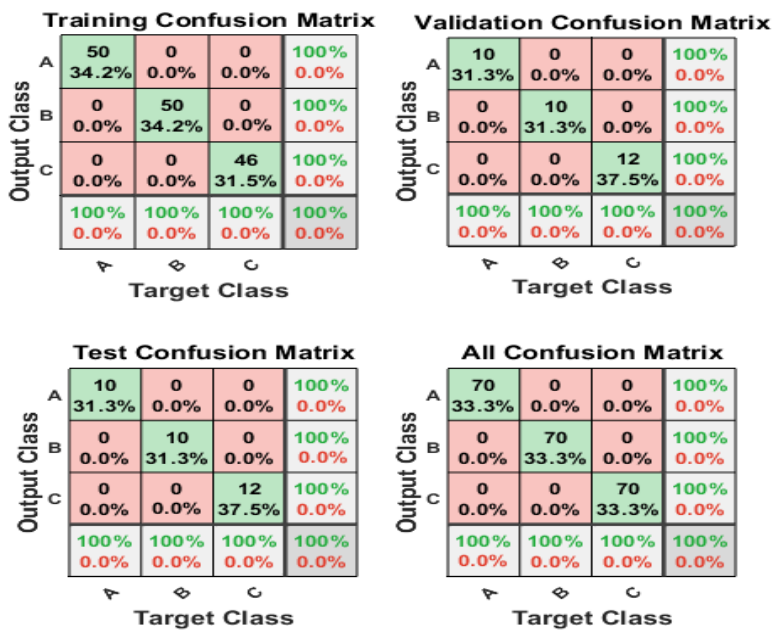
Figure 13. Confusion matrices of XLPE specimens classified with the test spectra of ( A ) unaged, ( B ) CuSO 4 , and ( C ) hydrothermally aged specimens.